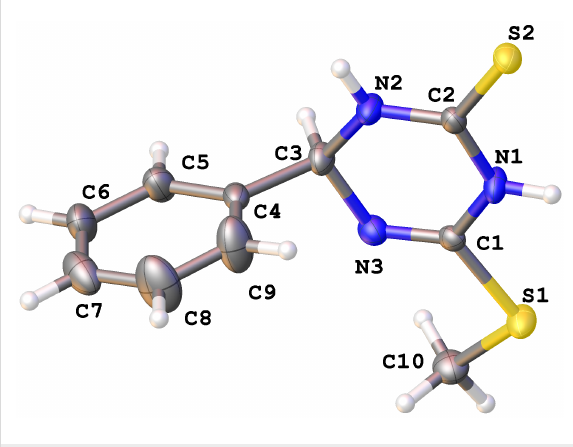
Figure 2: X-ray structure of 6-(methylthio)-4-phenyl-3,4-dihydro-1,3,5- triazine-2(1 H )-thione ( 6aa ) with thermal ellipsoids at 50% probability (CCDC